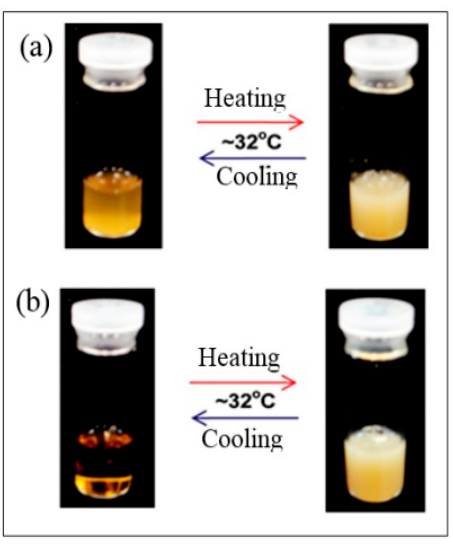
Figure 4. Visual appearance of the phase transition of ( a ) lignin- g -poly( N -isopropylacrylamide) copolymer and ( b ) lignin- g -poly( N -isopropylacrylamide) copolymer fully substituted macroinitiator. Reprinted (adapted) with permission from [32], copyright (2016) American Chemical Society.